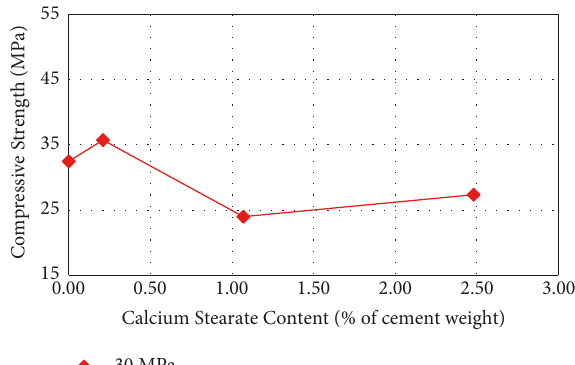
Figure 7: The compressive strengths of concrete grade 30 MPa.